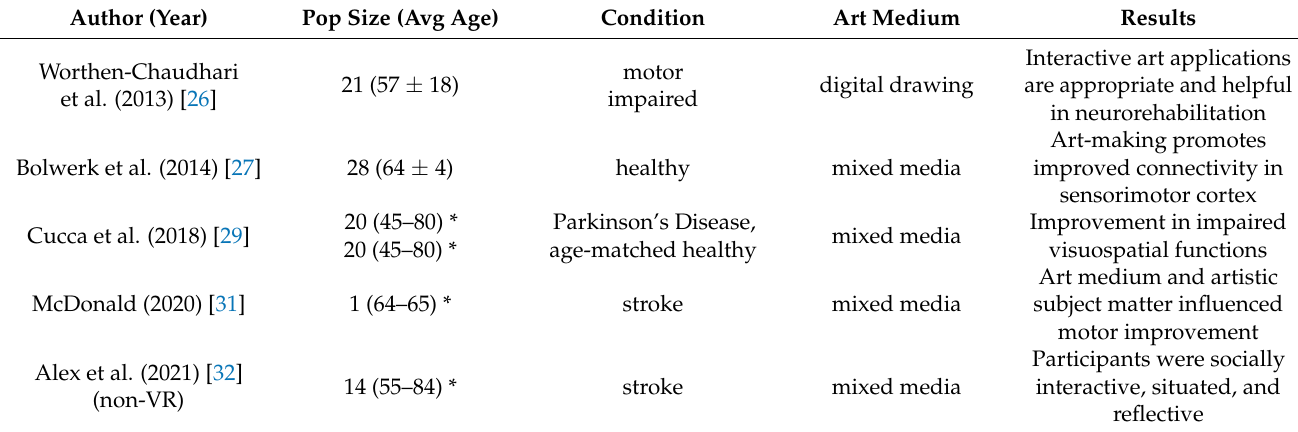
Table 2. Summary of studies in non-VR environment.